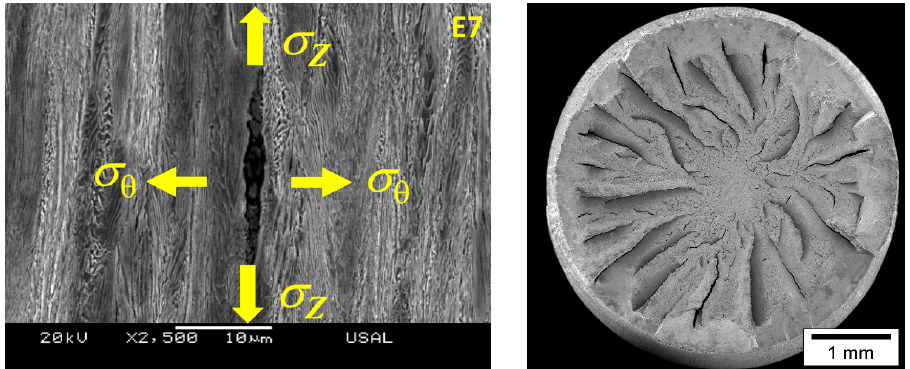
Figure 18. Anisotropic fracture behavior in a cold drawn pearlitic steel (E7).